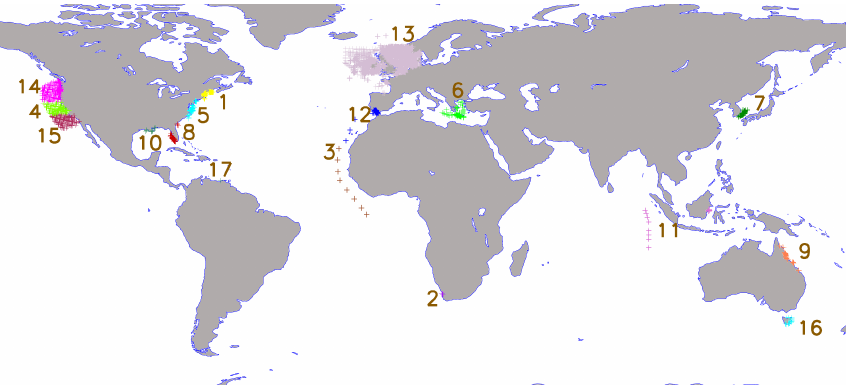
Figure 1. The distribution of the in situ data within the 17 CoastColour sites which are, numbered alphabetically, the coastal waters off (1) Acadia; (2) Benguela; (3) Cape Verde; (4) central California; (5) Chesapeake Bay; (6) the eastern Mediterranean Sea (referred to here- after as E. Md. Sea); (7) the East China Sea; (8) Florida; (9) the Great Barrier Reef region (hereafter GBR region); (10) Gulf of Mexico; (11) Indonesia; (12) Morocco and western Mediterranean Sea (hereafter Morocco-W. Md. Sea); (13) the North Sea region extending to the English Channel, the Celtic and Irish seas, the Bay of Biscay, and southern Brittany (all referred to as the North Sea); (14) Oregon– Washington; (15) southern California; (16) Tasmania; and (17) Trinidad and Tobago.